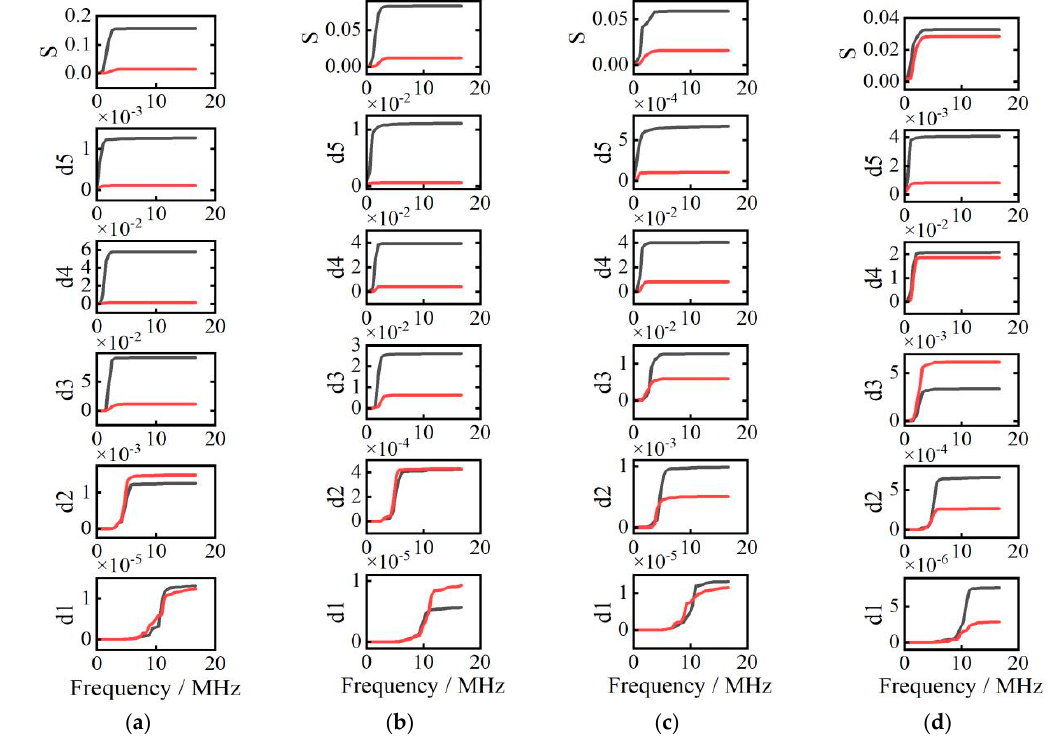
Figure 13. The curves of energy vs. frequency ( a ) crack depth is 0.2 mm, ( b ) crack depth is 0.3 mm, ( c ) crack depth is 0.4 mm, and ( d ) crack depth is 0.5 mm.